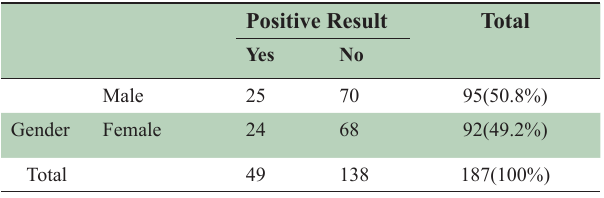
Chi-square value = 6.933 Table-V: Table of association among the gender and Gene Xpert.